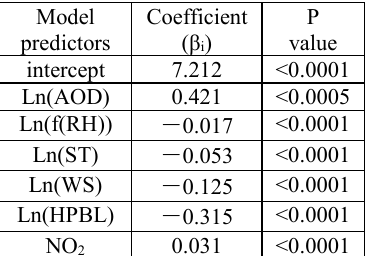
Table 2. Variable coefficients of nonlinear